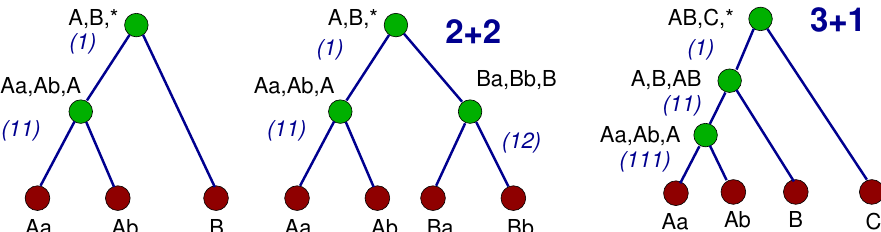
Figure 1. Typical hierarchical structure of triple and quadruple systems. Green circles denote subsystems designated as (primary, secondary, parent); pink circles are stars. Numbers in brackets indicate hierarchical levels.